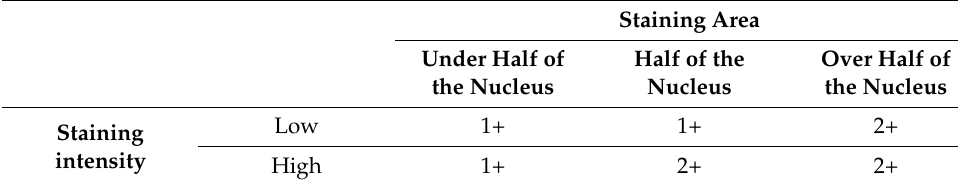
Table 2. Classification of immunopositive